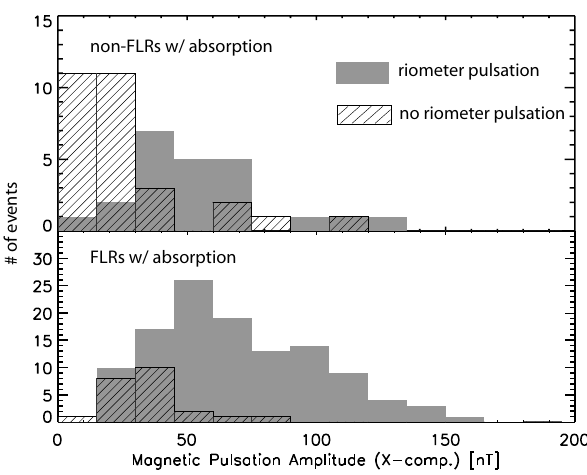
Fig. 10. Distributions of Pc5 wave amplitudes inducing (or not in- ducing) riometer Pc5 activity (top panel: non-FLRS , bottom panel: FLRs). Background absorption (sufficient particle population) is present for all events. The grey shaded region corresponds to those magnetic Pc5 waves which modulate electron precipitation, and the stripped region corresponds to those pulsations which do